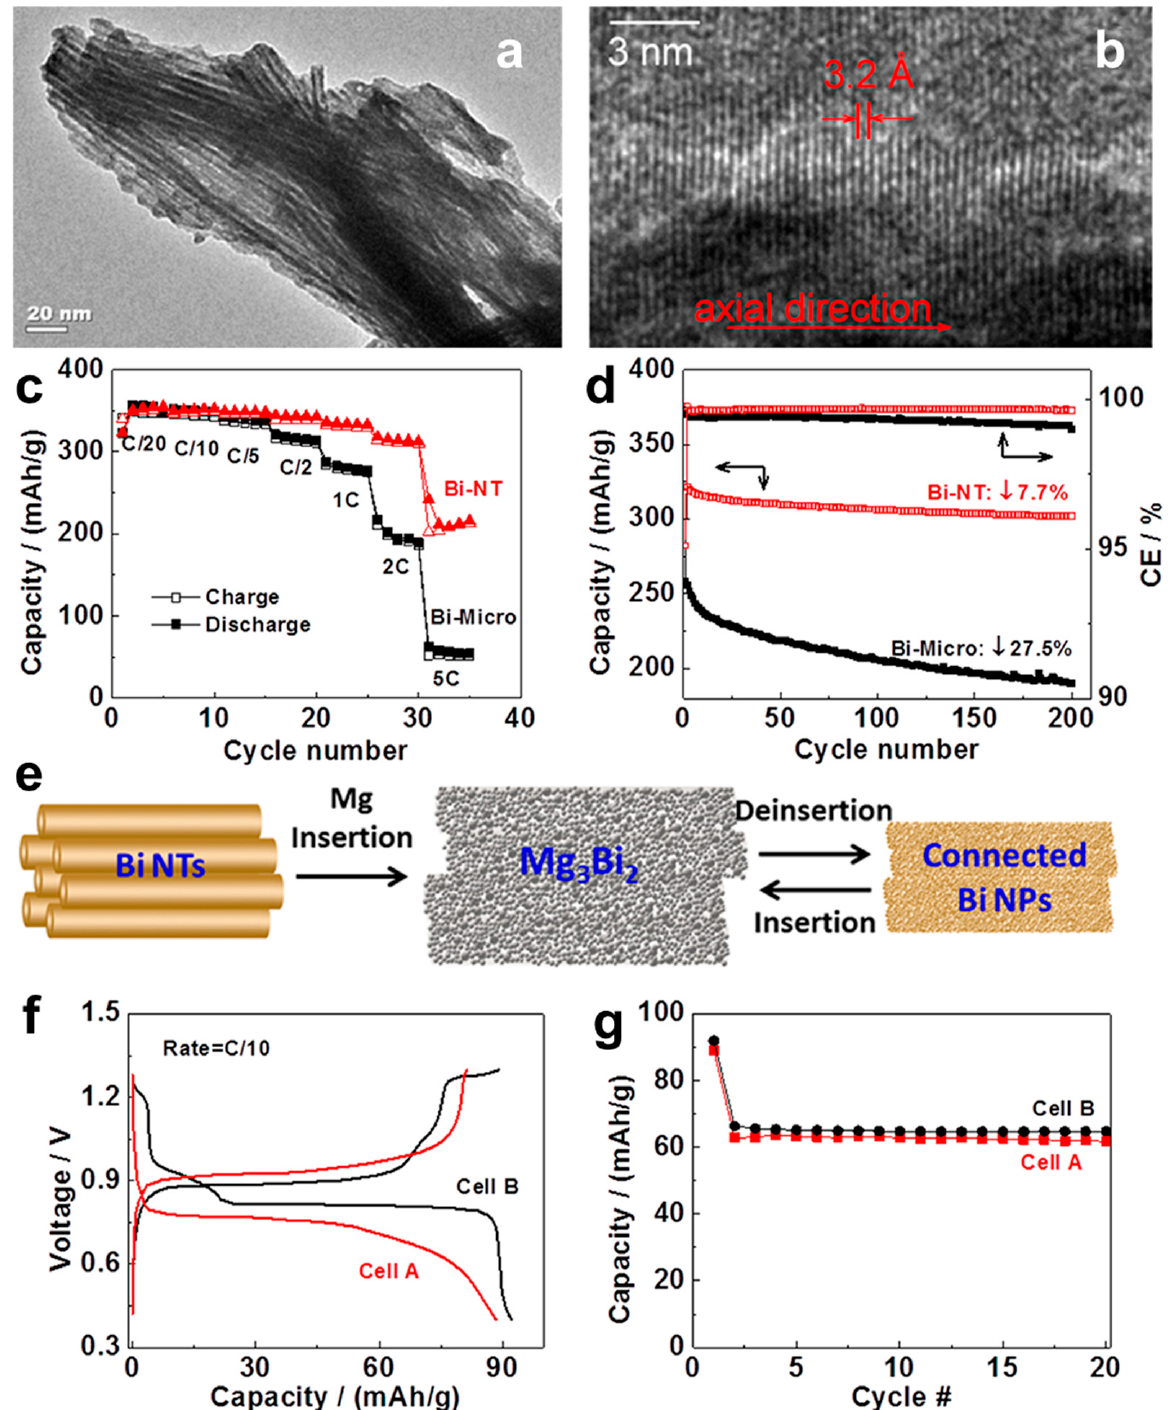
Figure 1. ( a ) TEM and ( b ) HRTEM images of Bi-NTs. ( c ) Rate performance ( the hollow triangle/implement triangles represent charge/discharge of Bi-NT ) and ( d ) cycling stability of Bi-NTs and micro-sized Bi as anodes for MIBs ( the two arrows in different directions represent capacity and Coulombic efficiency respectively ). ( e ) Schematic illustration of the structural transformation of Bi-NT electrode during the discharge/charge processes. ( f ) Discharge/charge profile and ( g ) cycling stability of an Mg 3 Bi 2 -Mo 6 S 8 cell. Cell configuration: (A) Mg 3 Bi 2 /0.4 M Mg(TFSI) 2 -diglyme/Mo 6 S 8 , (B) Mg 3 Bi 2 /0.1 M Mg(BH 4 ) 2 -1.5 M LiBH 4 -diglyme/Mo 6 S 8 . Reproduced with permission [24]. Copyright 2014, American Chemical Society.